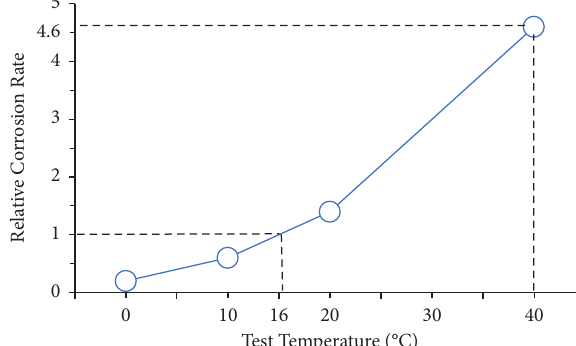
Figure 14: Correlation between temperature and relative corrosion rate [32], with permission from